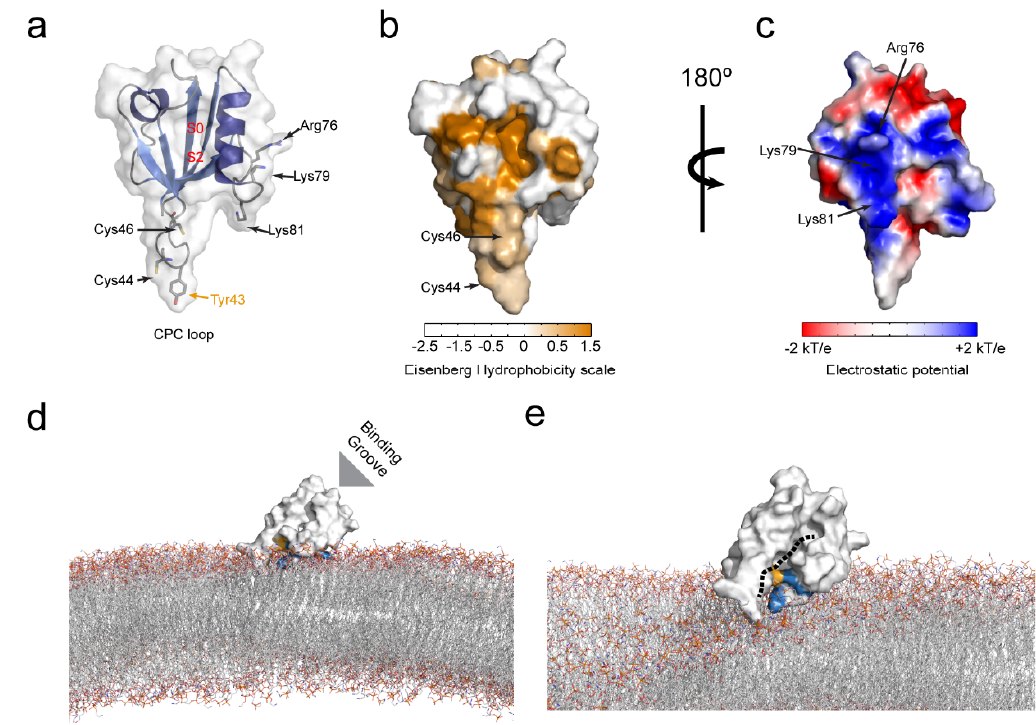
Figure 3. Molecular determinants of the PICK1 PDZ domain lipid membrane